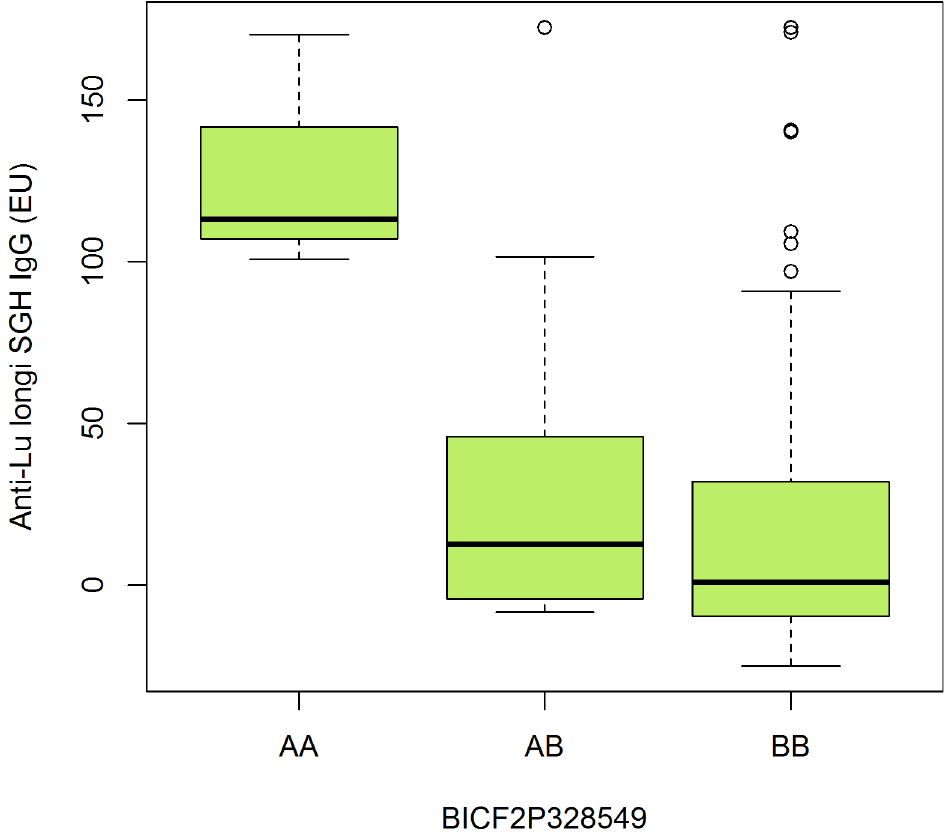
Fig 4. Comparison of anti- Lu . longipalpis SGH IgG levels among the genotypes of the SNP BICF2P328549, close to positional candidate CD180 . Higher anti- Lu . longipalpis SGH IgG levels in allele A carriers (A/B Illumina